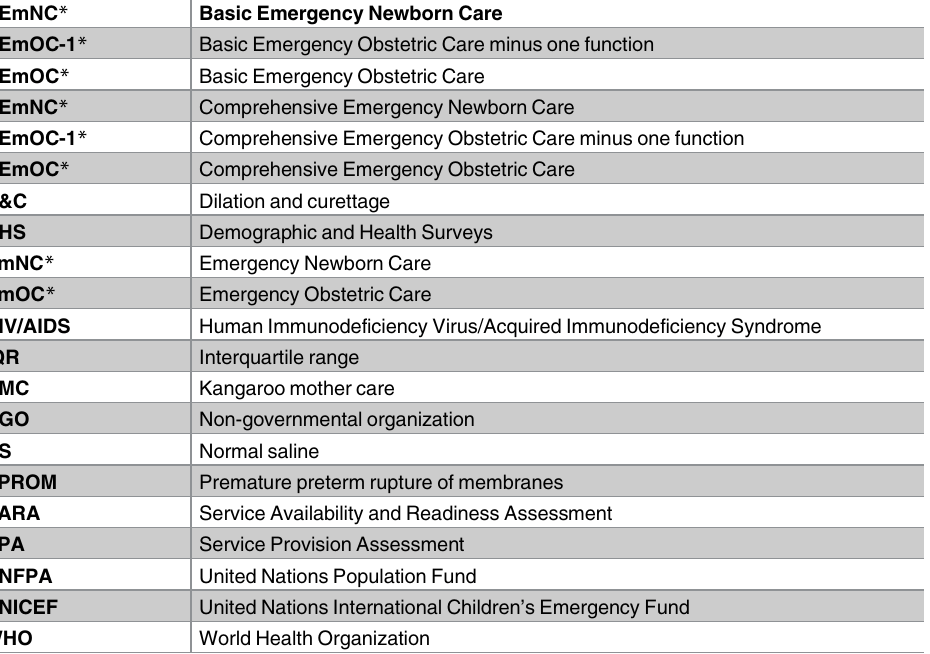
Table 1. Abbreviation